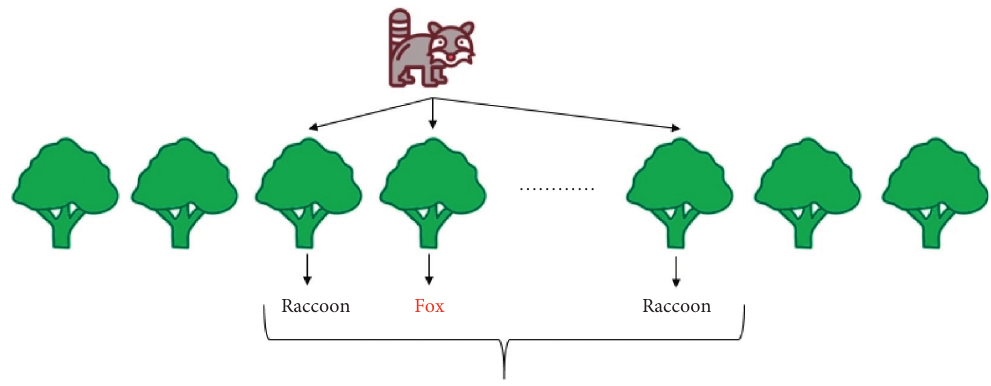
Figure 3: Random forest.